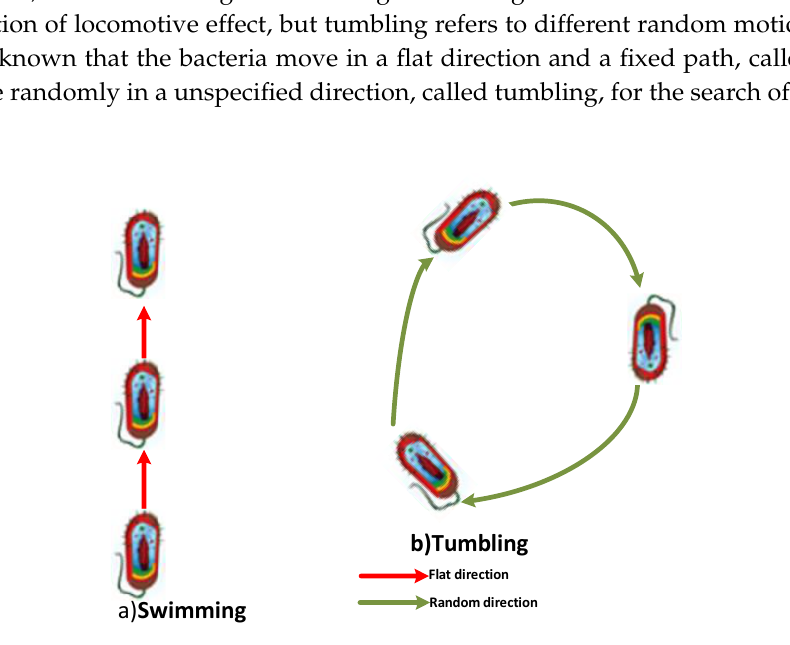
Table 1. Similarity between bacteria life and wireless sensor network (WSN). Bacteria foraging inspiration